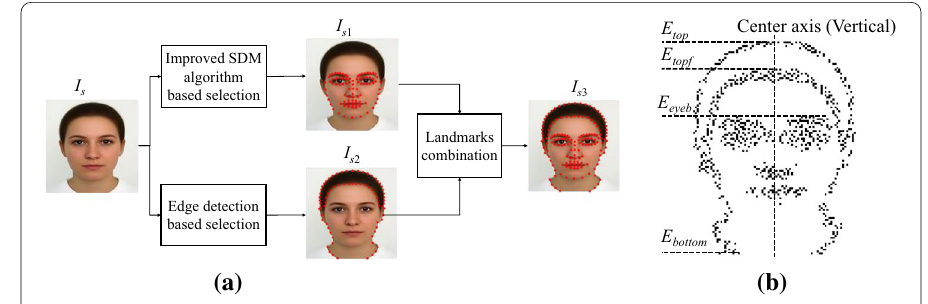
Fig. 4 The algorithm of landmark selection. a Lankmarks combinations; b edge outline of the